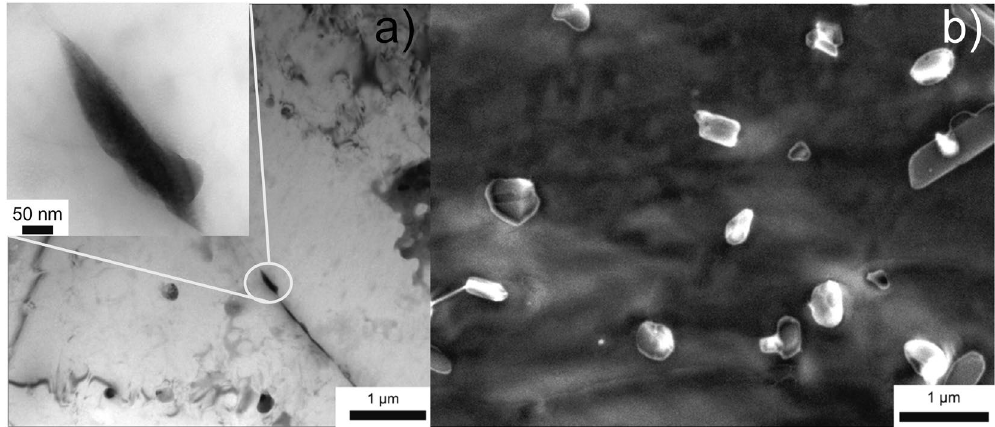
Figure 4. ( a ) TEM image of β -phase precipitates decorating the grain boundary of AA5083 sensitised at 150 °C for 8 days, and ( b ) HR-SEM image revealing the same β -phase from a Ga-embrittled fracture surface of the same specimen from the image in ( a